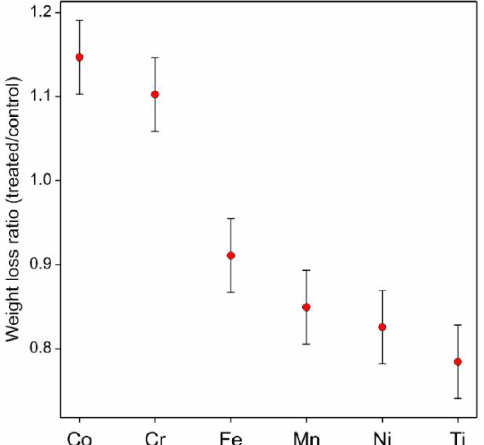
Figure 1. Loss in weight of thin yellow cedar wood veneers treated with different metal